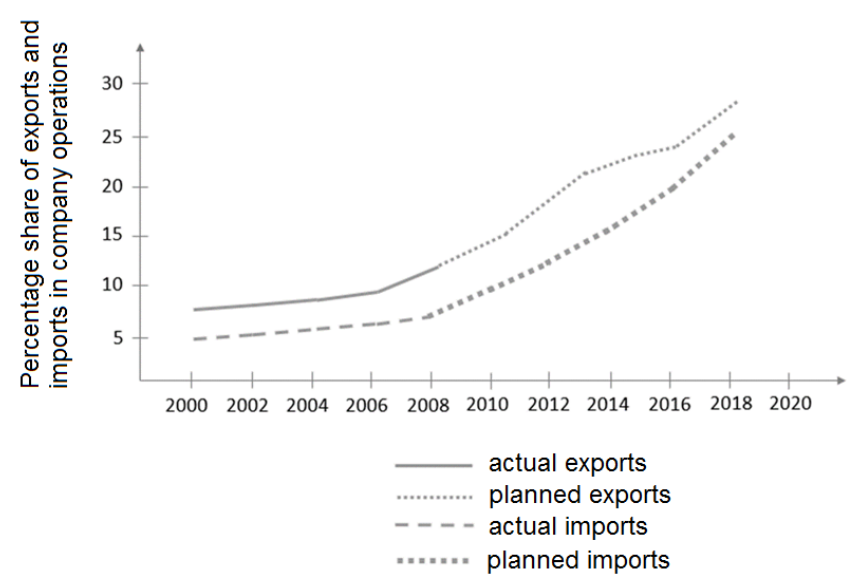
Figure 3. The percentage share of exports and imports in companies’ trading in the period 2000 to 2008, with a projection until 2020 (expressed in %) (Source: Own study).